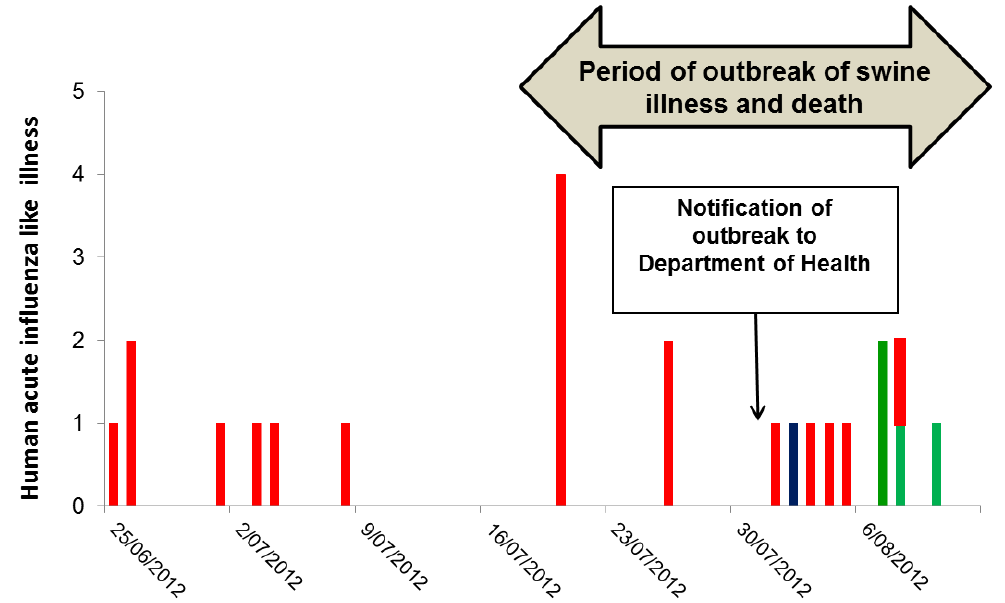
Figure 1. Date of onset of influenza-like illness and respiratory virus detections in 23 workers at a piggery in WA preceding and during an outbreak of respiratory tract illness and deaths in swine. The red columns are those with respiratory illness without laboratory confirmation either because they were not tested (17 workers) or because the results were negative or inconclusive. The blue column is confirmed seasonal A(H3N2) and the green are confirmed RV infections. Initial serologic testing at the DAFWA had suggested influenza infection and on 4 August 2012, a site visit was made by officers from the CDCD and the DAFWA.